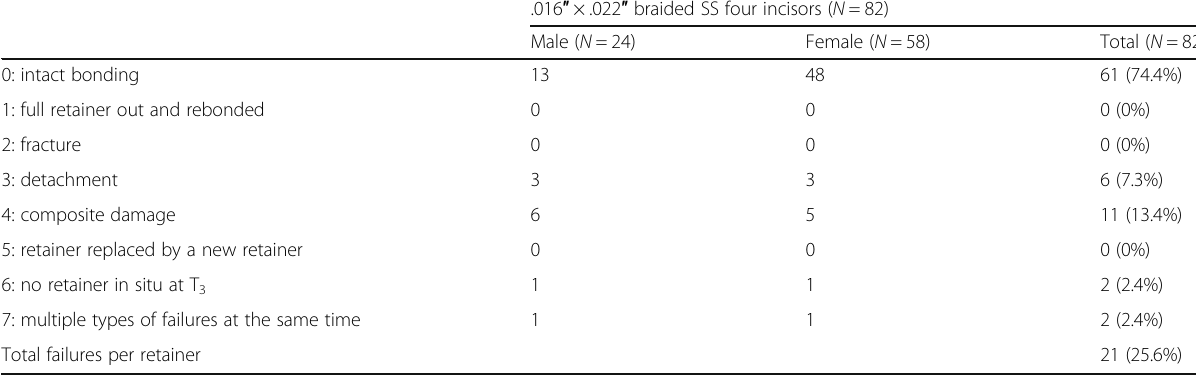
Table 3 Type of the first failure for the